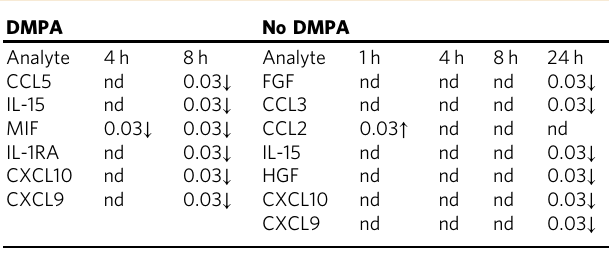
Table 2 GRFT/CG FDI-induced changes in vaginal cytokines and chemokines in DMPA-treated and untreated